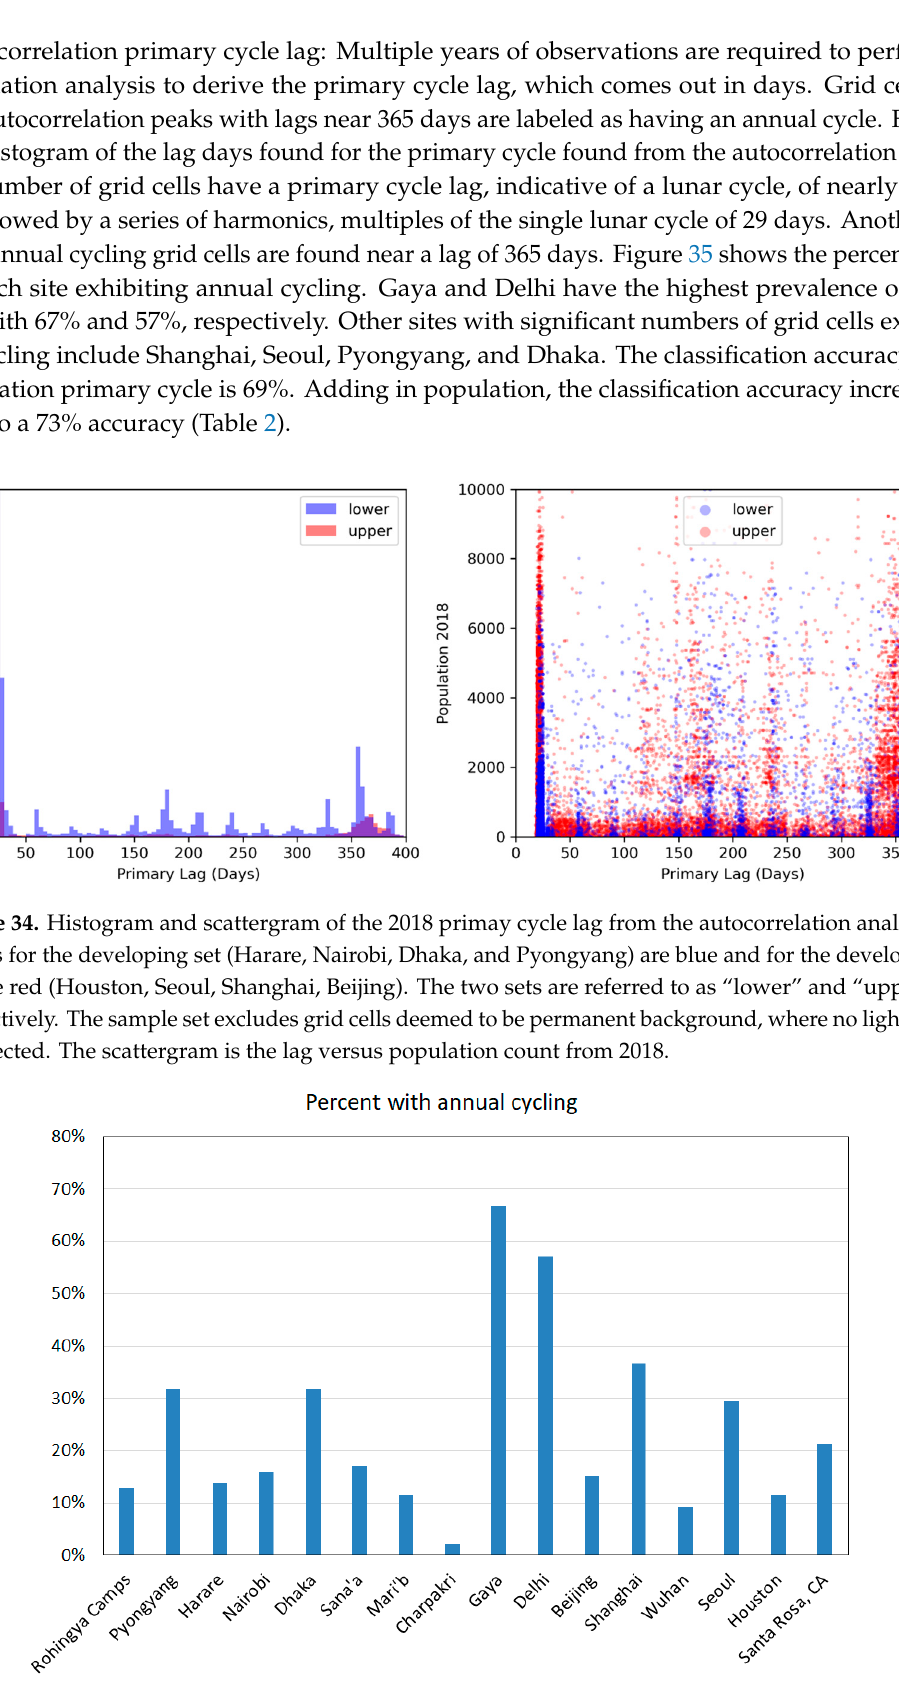
Figure 35. Picket-fence chart of the percent of grid cells with annual cycling for each of the test sites. Long-Term Trend (LTT): Overall, the developed sites have lower long-term trend slopes than the developing sample set (Figure 36). Figure 37 shows that many of the study sites have near zero long-term trend slopes, including the Rohingya Camps, Pyongyang, Delhi, and Santa Rosa. Two sites had negative LTT slopes: Harare and Sana’a. In Sana’a, this is due to the slow recovery process following the aerial bombing. In Harare, the negative slope appears to be an indicator of supply reductions. Other sites have positive slopes, with Nairobi and Wuhan having the largest slopes—an indicator of power supply growth.